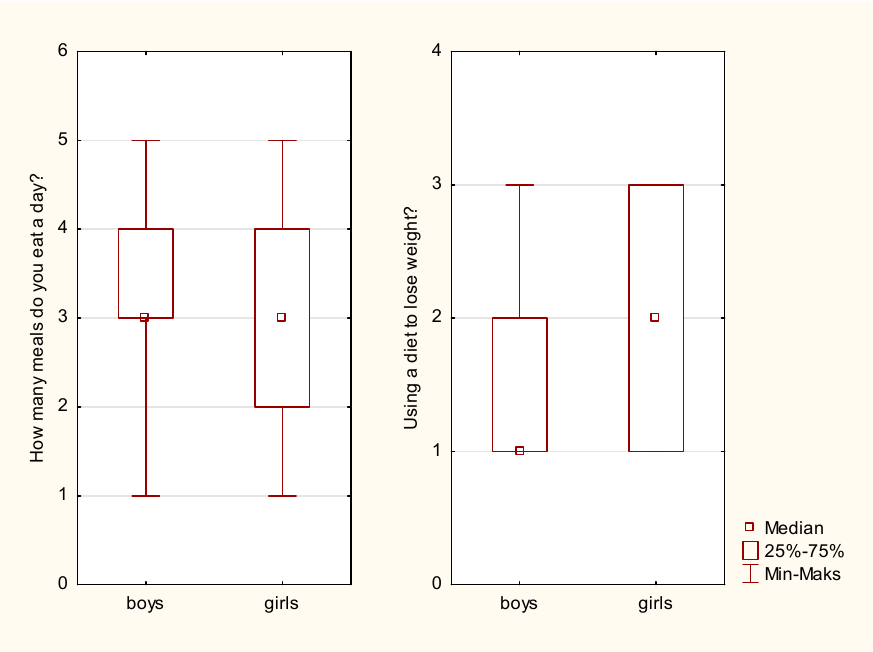
Figure 1. Number of meals and dieting—comparison by gender.